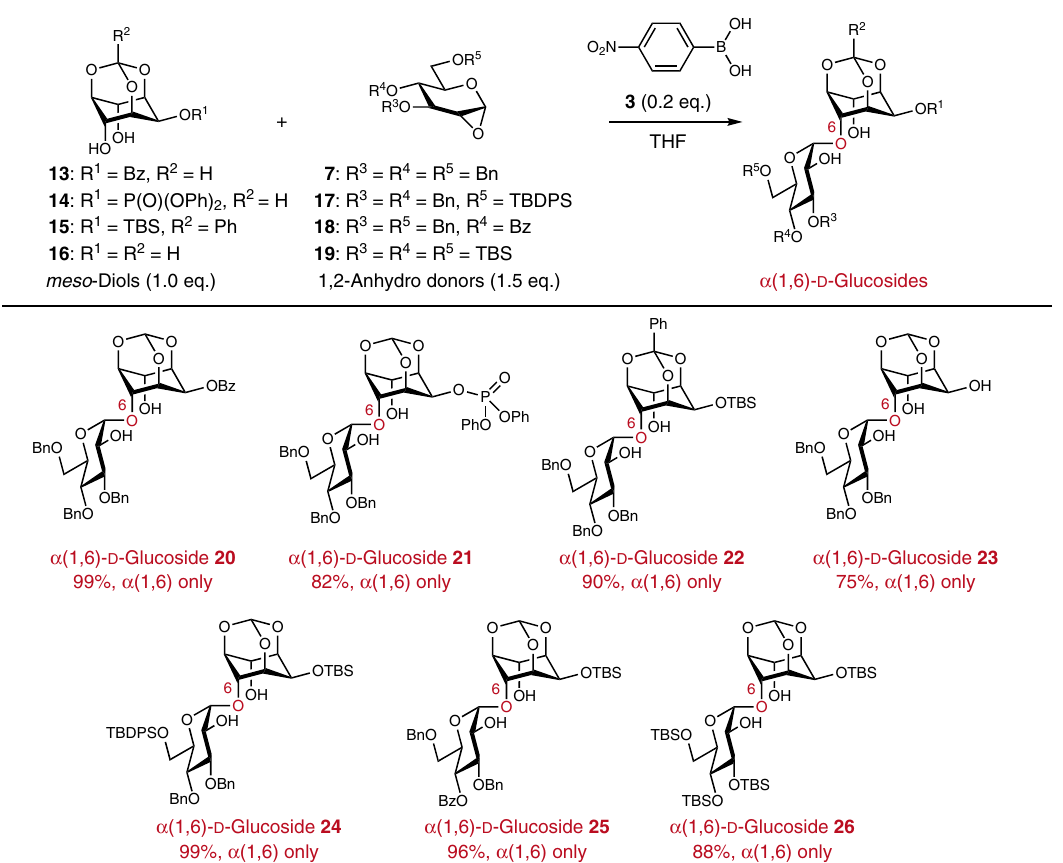
Fig. 3 Substrate scope of the protecting groups in the desymmetric glycosylation using 1,2-anhydro-d-glucose. Bz benzoyl, Ph phenyl, TBDPS tert-